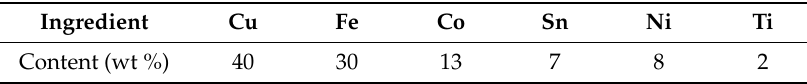
Table 1. Composition of metallic-based